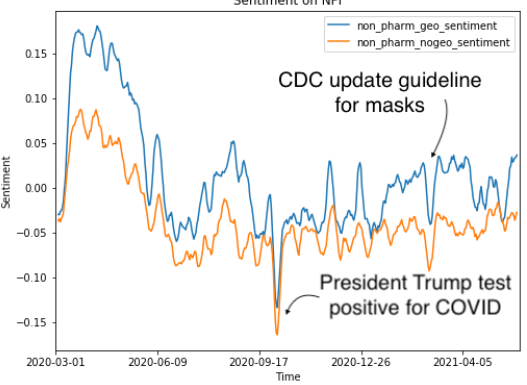
Figure 5. Sentiments towards